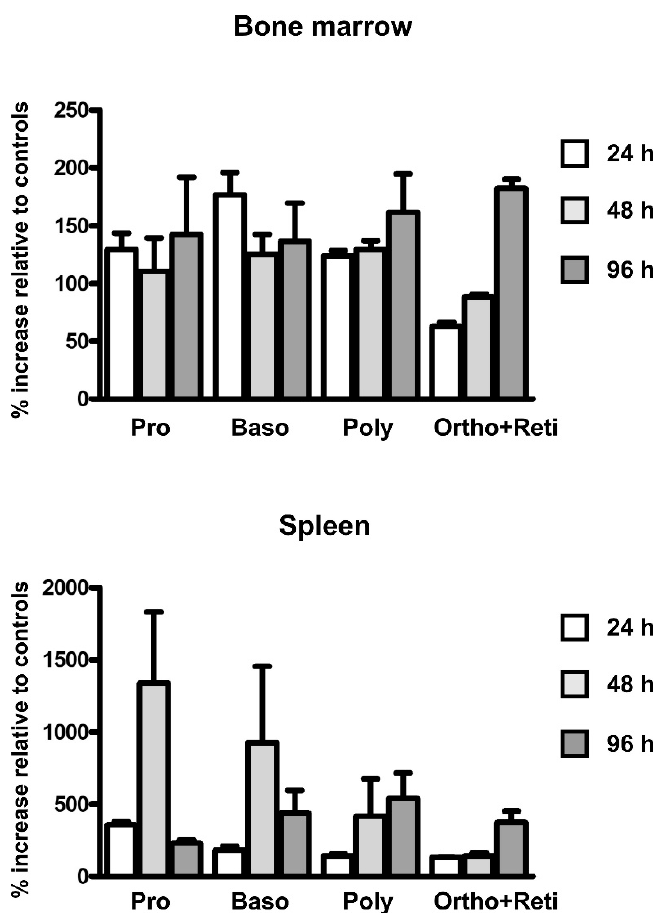
Figure 4. Single injection of EPO increases the number of proerythroblasts and basophilic erythroblasts in the spleen 48 h after treatment. EPO was administered at 200 U/mouse; cell populations were obtained at indicated intervals by FACS sorting. Values represent the relative increase of cell populations in EPO-treated animals as compared to control animals (100%). n = 3, values were obtained from three independent experiments. Pro: Proerythroblasts; Baso: Basophilic erythroblasts; Poly: Polychromatophilic erythroblasts; Ortho + Reti: Orthochromatic erythroblasts and reticulocytes.